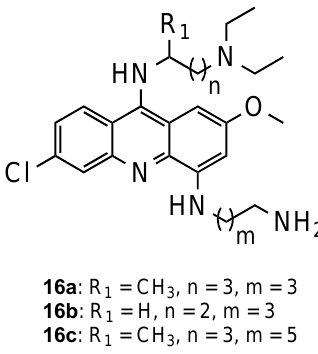
Figure 10. QN derivatives developed by Fonte and co-workers [21] .